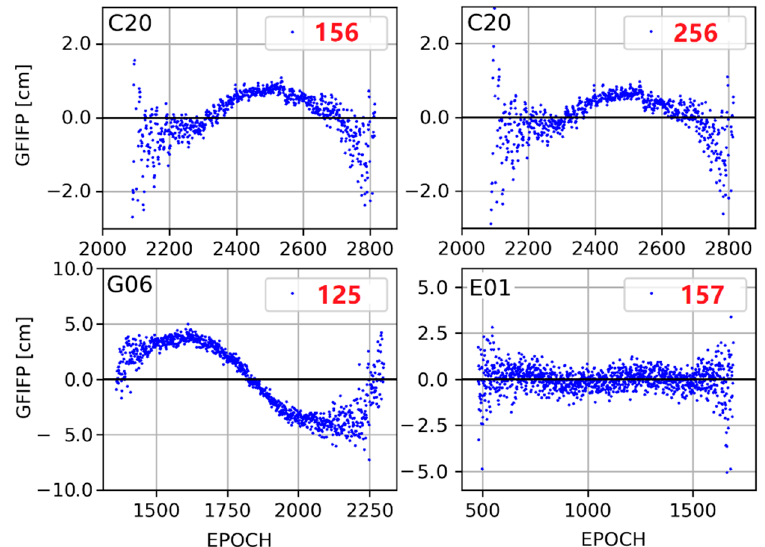
Figure 7. The geometry-free ionosphere-free phase (GFIFP) combinations as a function of the epoch for the BD3 C20 satellite (B1C / B2a / B3I and B1I / B2a / B3I) as well as the GPS G06 and Galileo E01 satellites. The legends 1 / 2 / 5 / 6 in satellite C20 stand for B1C / B1I / B2a / B3I respectively, and 1 / 2 / 5 in G06 represent L1 / L2 / L5, and 1 / 5 / 7 in E01 stand for E1 / E5a / E5b, respectively.